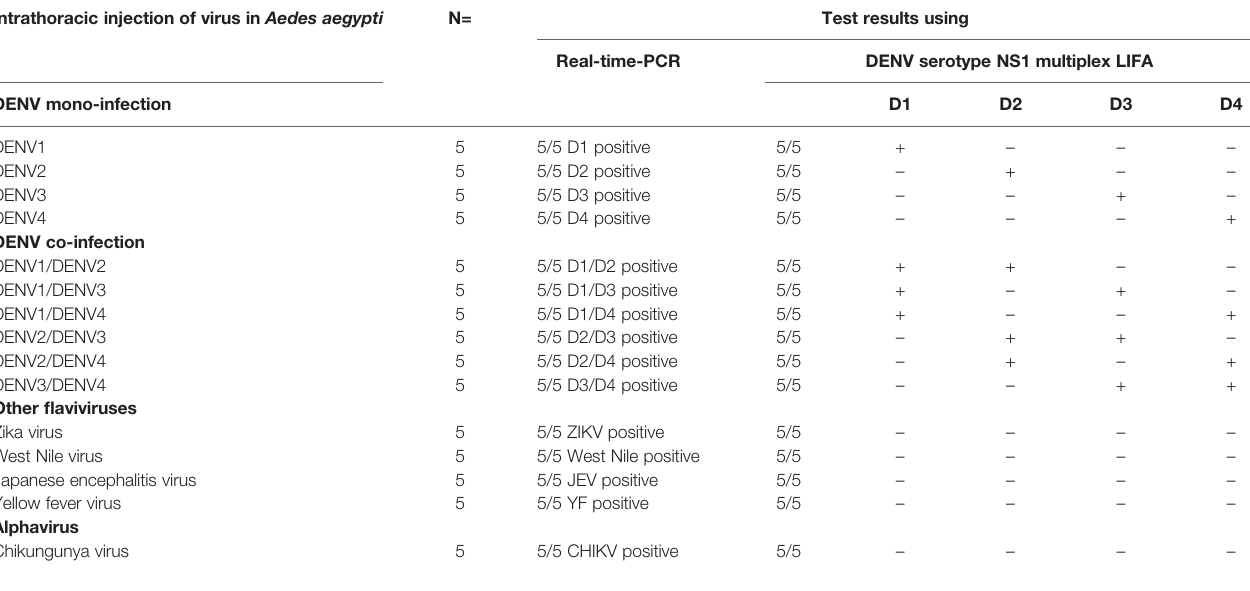
TABLE 9 | Validation results for DENV serotype NS1 multiplex LFIA for mosquitoes infected with fl aviviruses or Chikungunya virus. Intrathoracic injection of virus in Aedes aegypti